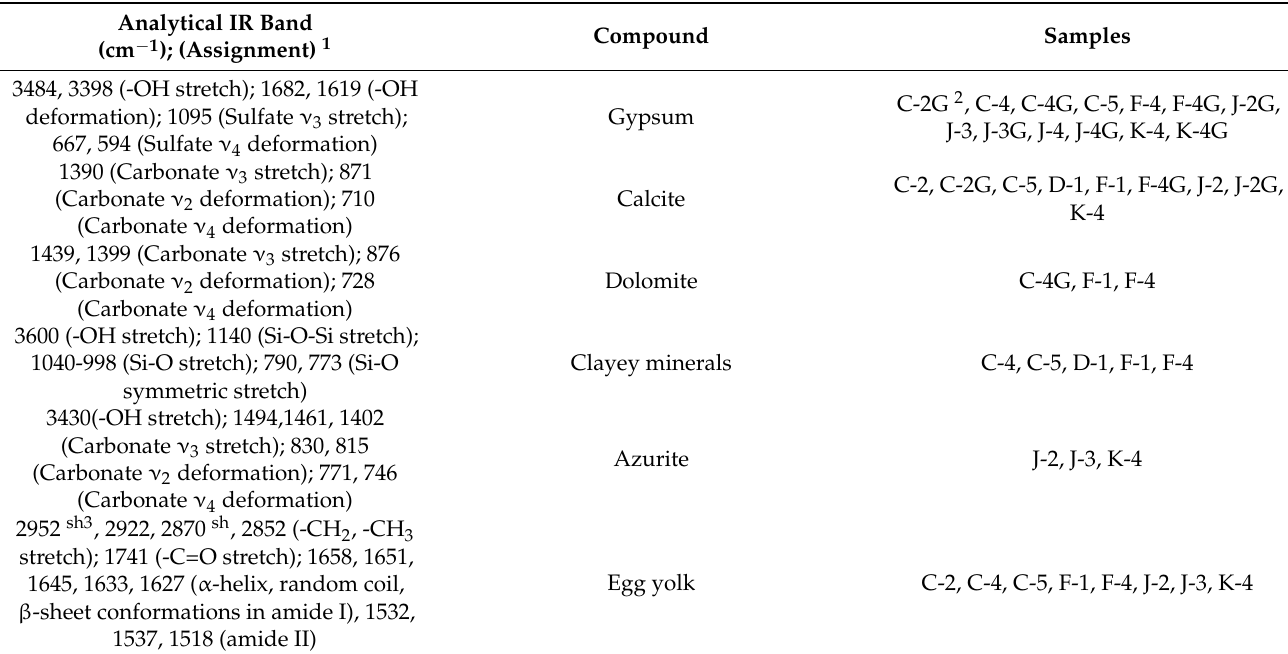
Table 2. Position of the IR absorption bands found in the samples analyzed, assignment to functional groups and organic